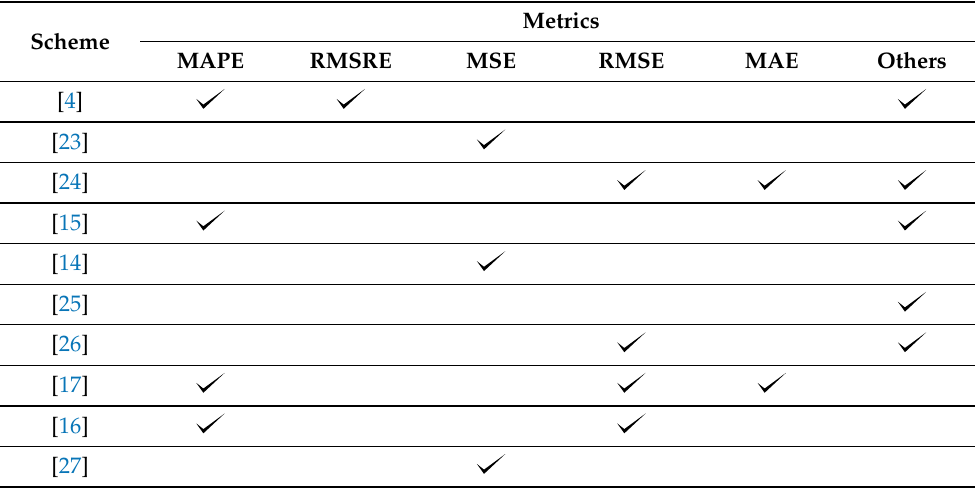
Table 4. Comparison of error/accuracy metrics used in the DL